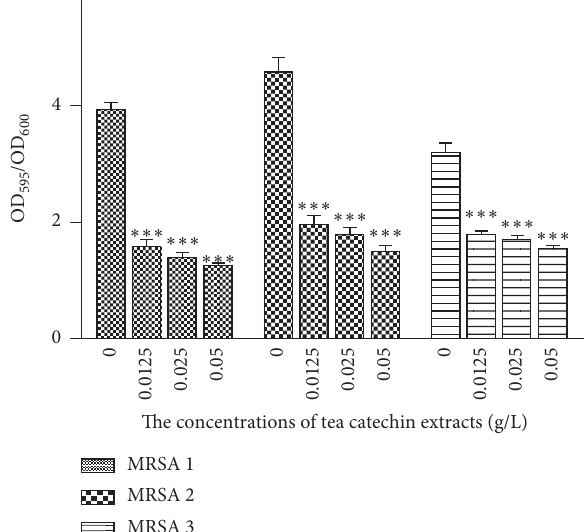
Figure 2: The influence of tea catechin extracts on the biofilm formation of MRSA isolates. Biofilm formation was assayed by crystal violet staining in 96-well polystyrene microtiter plates. Growth of each S. aureus isolate was monitored by resuspending the biomass of at least three wells per strain and the measurement of the OD 600 . The amount of biofilm was normalized to the respective growth as assessed by OD 600 . Data were the mean ± SEM of three independent experiments ( ∗∗∗ P < 0 . 001).